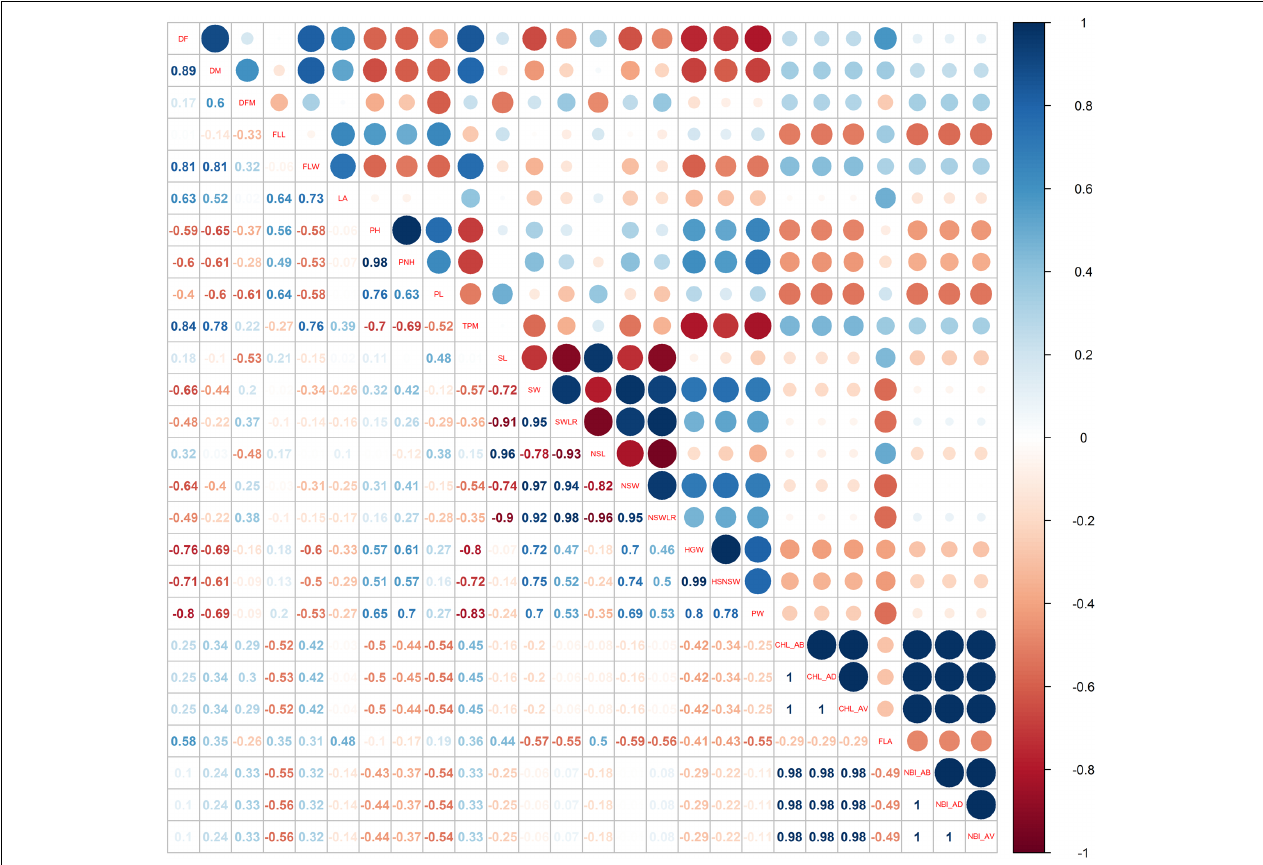
FIGURE 3 | Pearson correlations among the phenotypic traits used for the genome-wide association study recorded in the LW cultivation